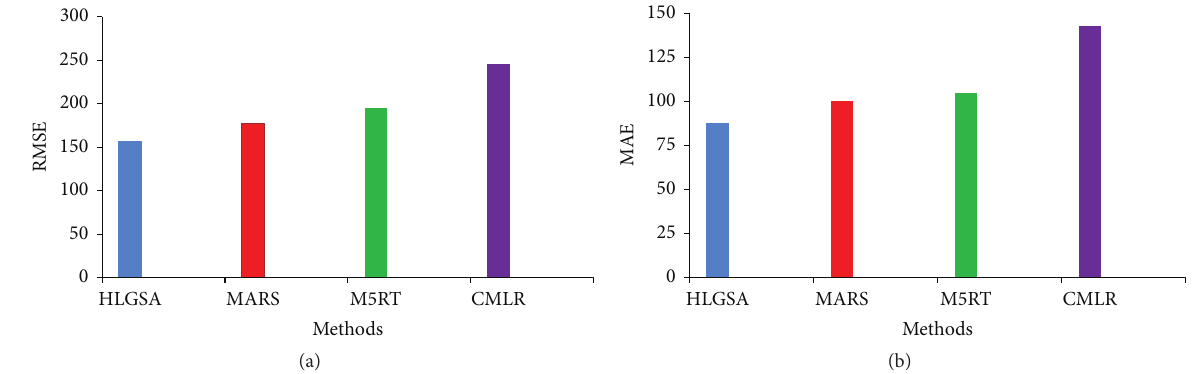
Figure 7: Overall errors of forecasted river flow using all normal models for Shyok catchment.